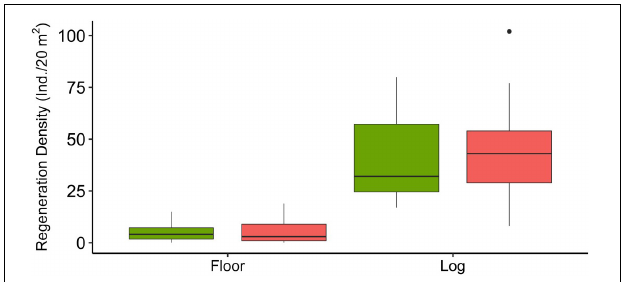
FIGURE 6 | Boxplot showing the total number of regenerations found on nurse logs versus the forest floor. Pink boxes represent control sites while green boxes represent habitation sites. Outliers are represented as black dots and represent samples that are > 1.5 times the interquartile range. There was significantly more recruitment on nurse logs than on the forest floor (GLM, Est = 2.13, Z = 22.86, p < 0.01). Nurse logs made up on average 23.43% ± 3.33% of the forest floors on habitation sites vs. 19.55% ± 2.14% on control